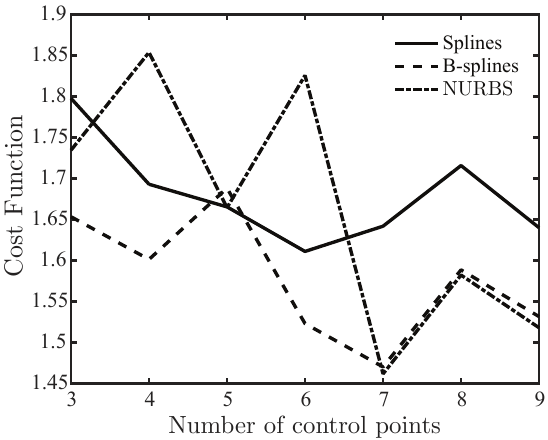
Figure 3. The final value of cost function using different numbers of control points.